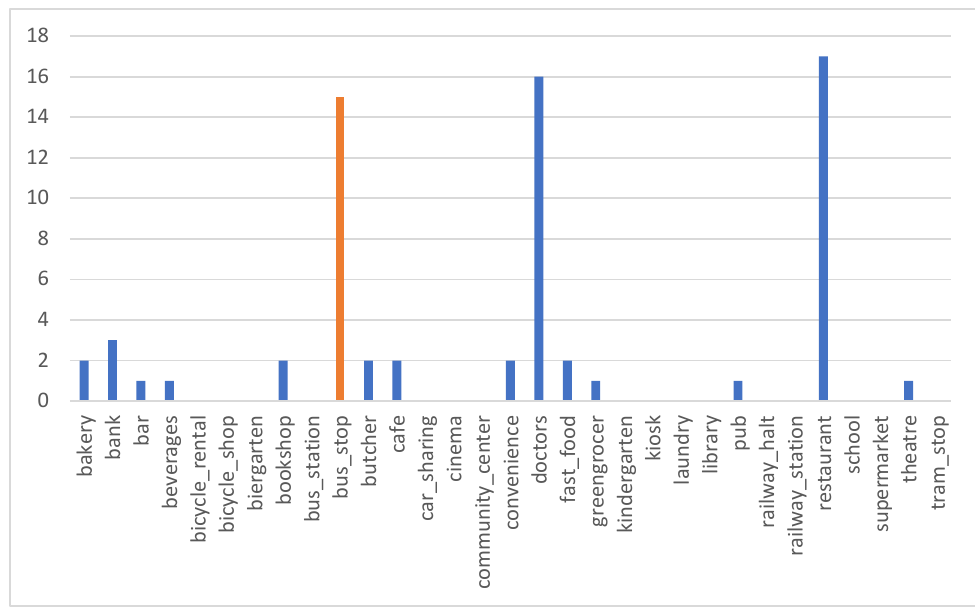
Figure 17. Number of POIs in the vicinity of 500 m in the surrounding of the company HIPP in Pfaffenhofen an der Ilm.